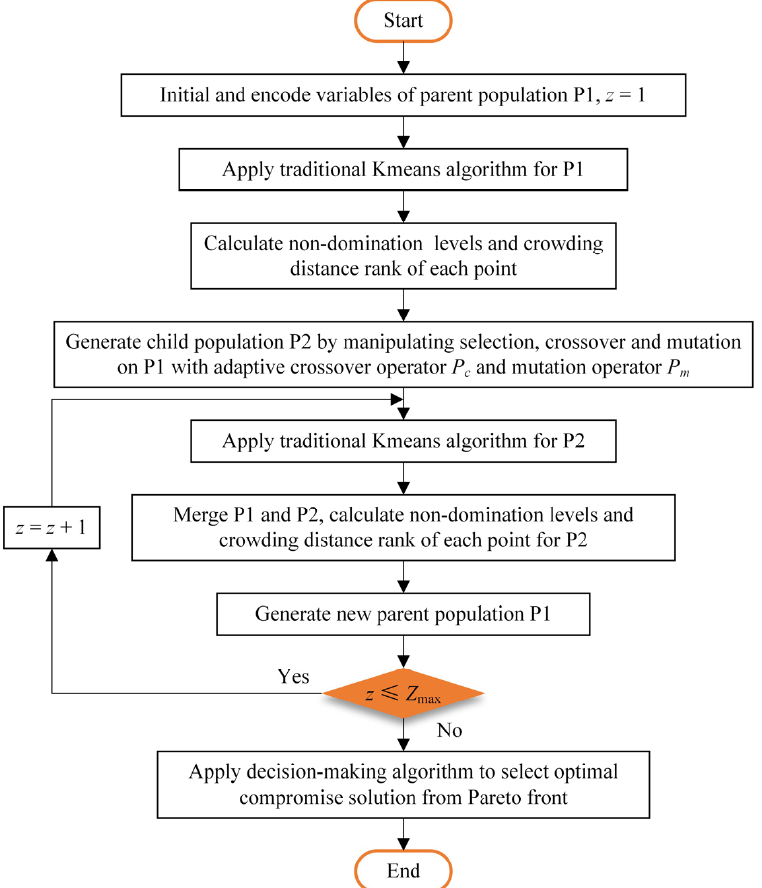
Figure 3. The flowchart of MNSGA-II-Kmeans algorithm.